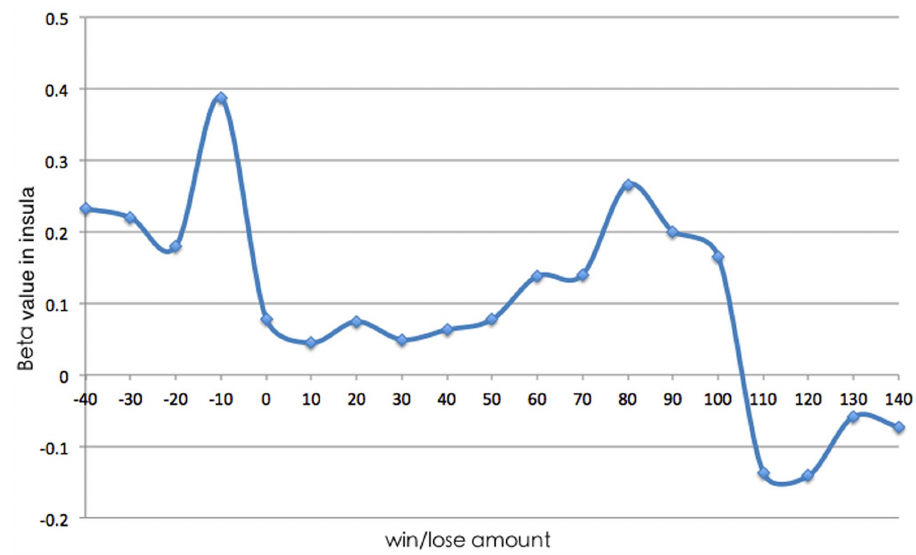
Figure 6. Beta values in insula in different win/lose situations.